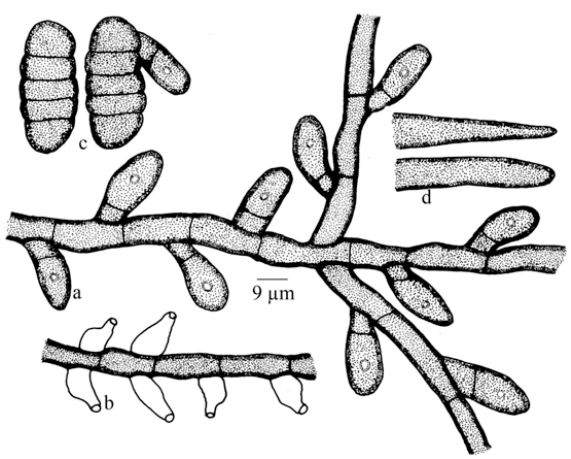
Figure 7. Irenopsis andamanica sp. nov. a - Appressorium; b - Phialide; c - Ascospores; d - Perithecial